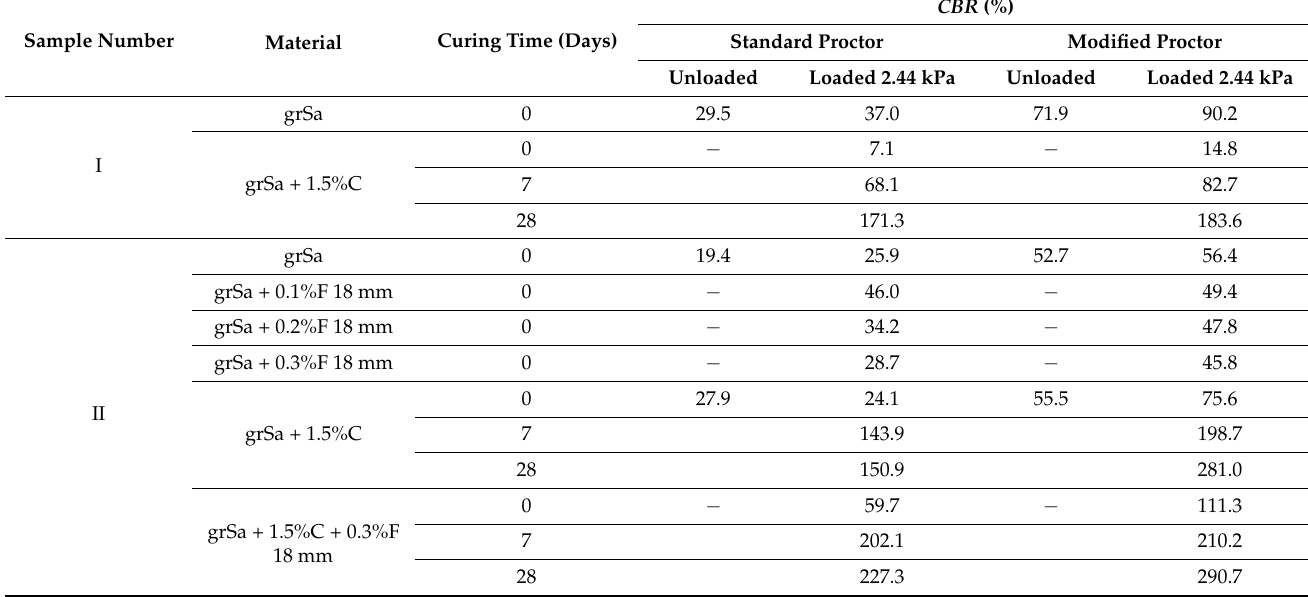
Table 3. California bearing ratio test